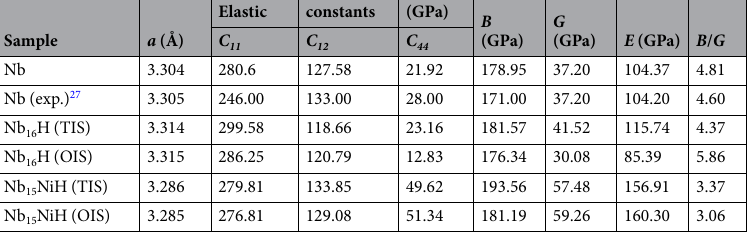
Table 2. Calculated lattice constants ( a ), elastic constants ( C 11 , C 12 , C 44 ), bulk modulus ( B ), shear modulus ( G ), Young’s modulus ( Y ), and B / G of Nb 16 H and Nb 15 NiH phases. The calculated results of pure Nb and experimental values 27 are also included for